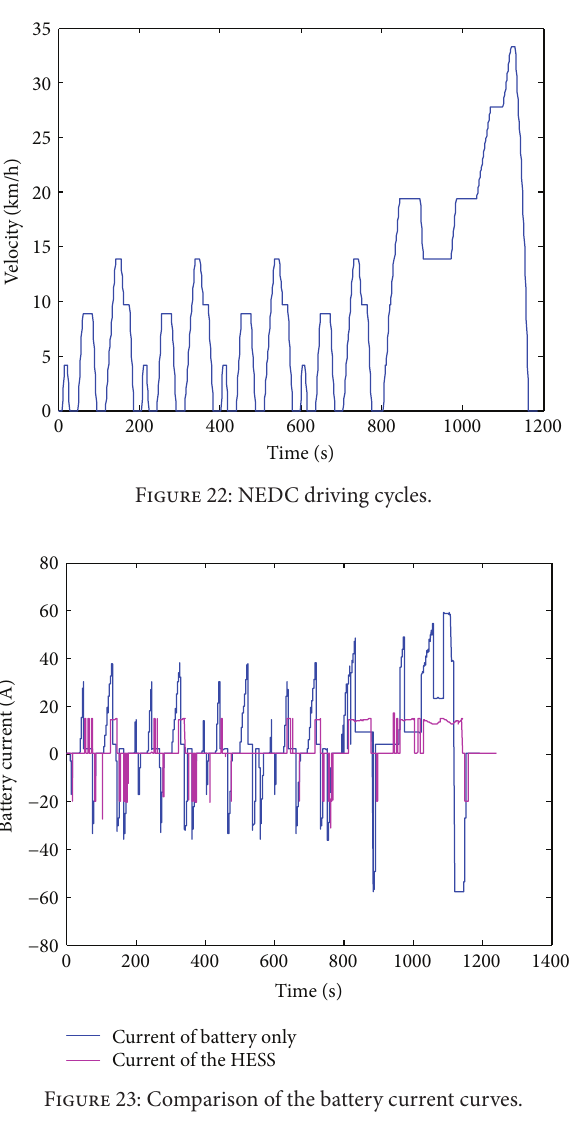
Figure 23: Comparison of the battery current curves.